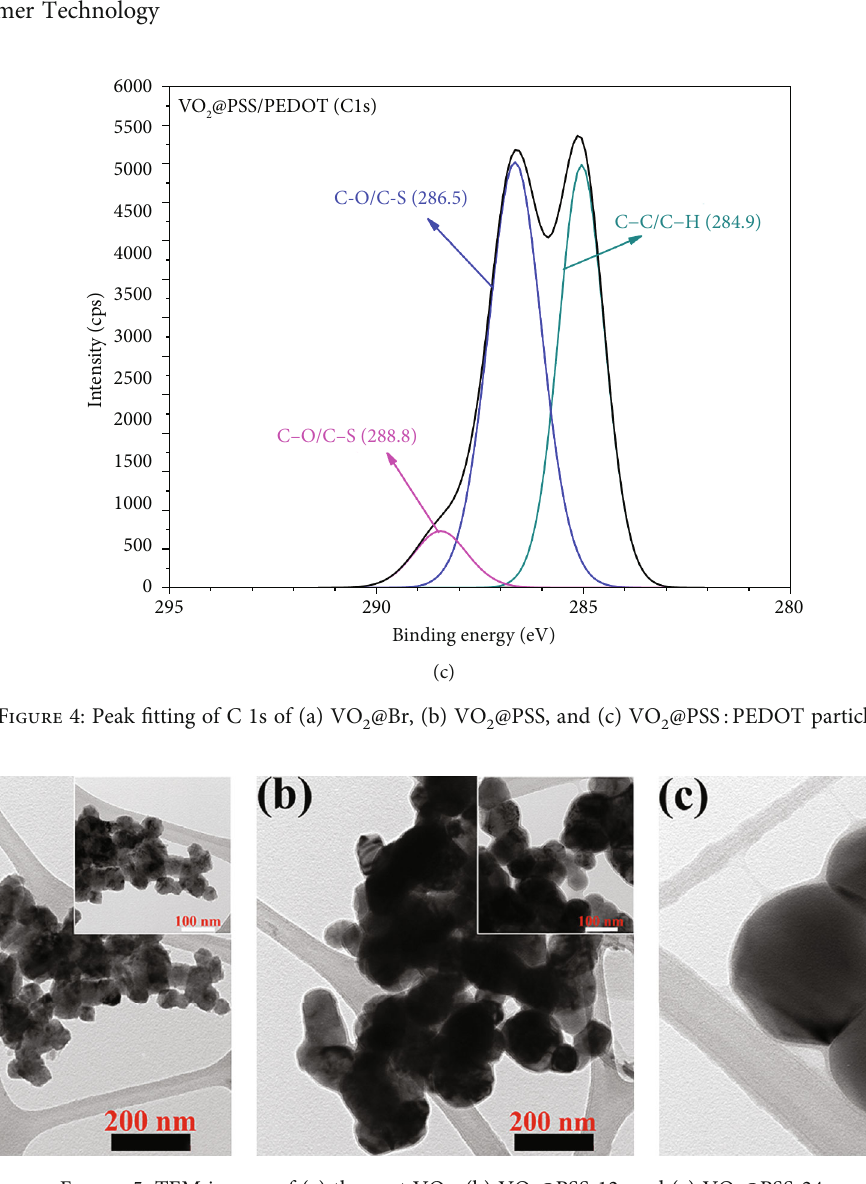
, (b) VO @PSS-12, and (c) VO 2 2